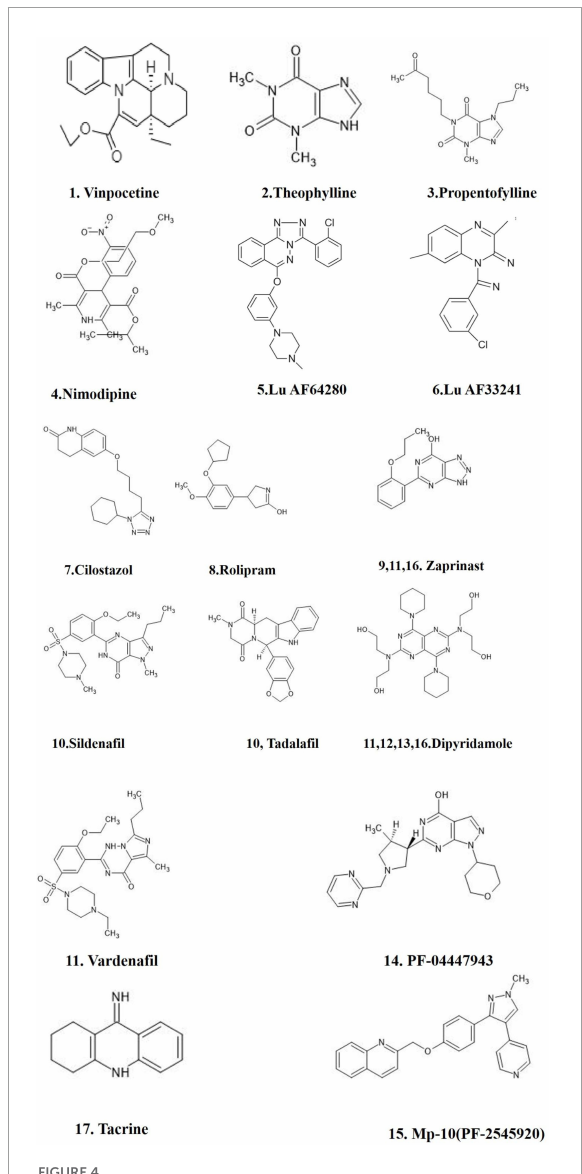
derived compounds with PDE inhibitory activity, as well as their possible relevance in Alzheimer’s